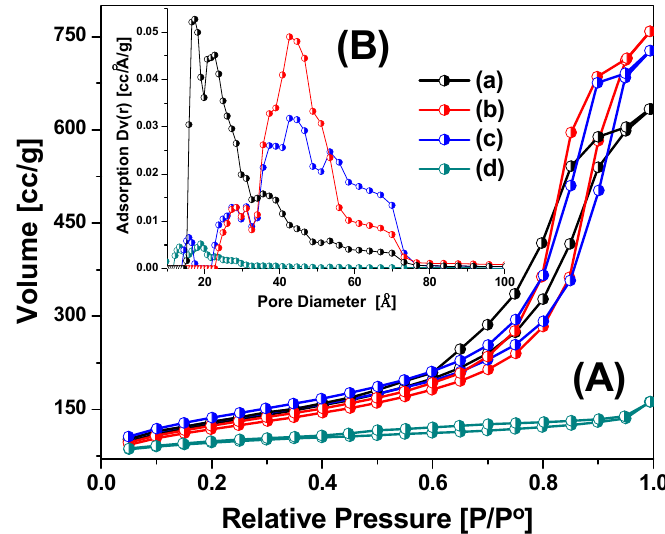
Figure 4. ( A ) N 2 adsorption-desorption isotherms and ( B ) pore-size distribution patterns of ( a ) MFI-40, ( b ) MFI-45, ( c ) MFI-50 and ( d ) Zeolyst.